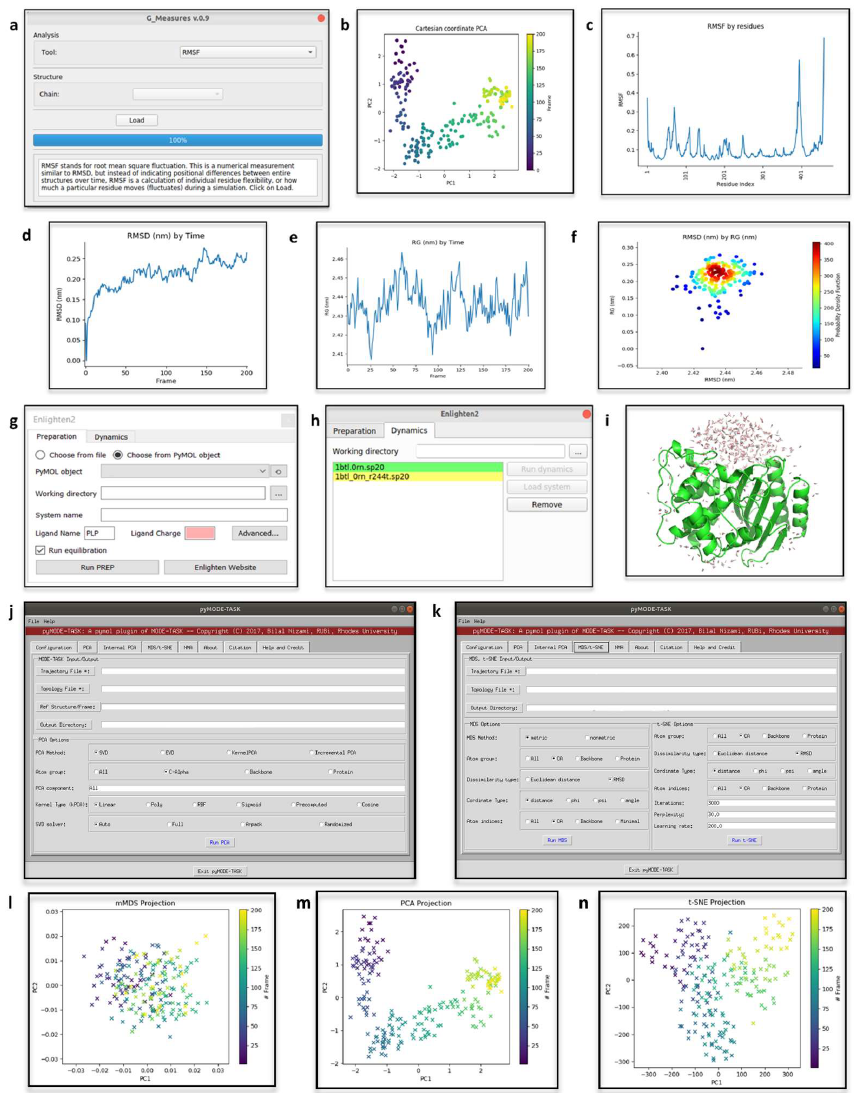
Figure 4. ( a ) Geo-Measures GUI (Ubuntu Linux OS) to run a Root Mean Square Fluctuations (RMSF) analysis on the MD-trajectory loaded in PyMOL. ( b – f ) Plots of the results of the analyses carried out from within Geo-Measures. In this example, the analyzed data were MD simulations of the multiple endocrine neoplasia type 1 (MEN1) [106]. On such trajectories, PCA ( b ), RMSF ( c ), RMSD ( d ), Rg ( e ) and PDF between RMSD and Rg values ( f ), were computed. ( g ) Enlighten2 GUI (Windows OS) to set-up the parameters for molecule preparation. ( h ) Enlighten2 GUI (Ubuntu Linux OS) to run the MD simulation. ( i ) Enlighten2 rendering of the solvent cap in PyMOL. In this example, the tutorial provided on the Enlighten2 website for beta-lactamase TEM-1 (PDB-ID: 1BTL; [107]) was followed. ( j , k ) Appearance of pyMODE-TASK (Ubuntu Linux OS) tabs for the setup of PCA, MDS and t-SNE analyses. ( l – n ) Plots provided by pyMODE-TASK to show the results of the PCA, MDS and t-SNE analyses carried out on MEN1 MD simulations